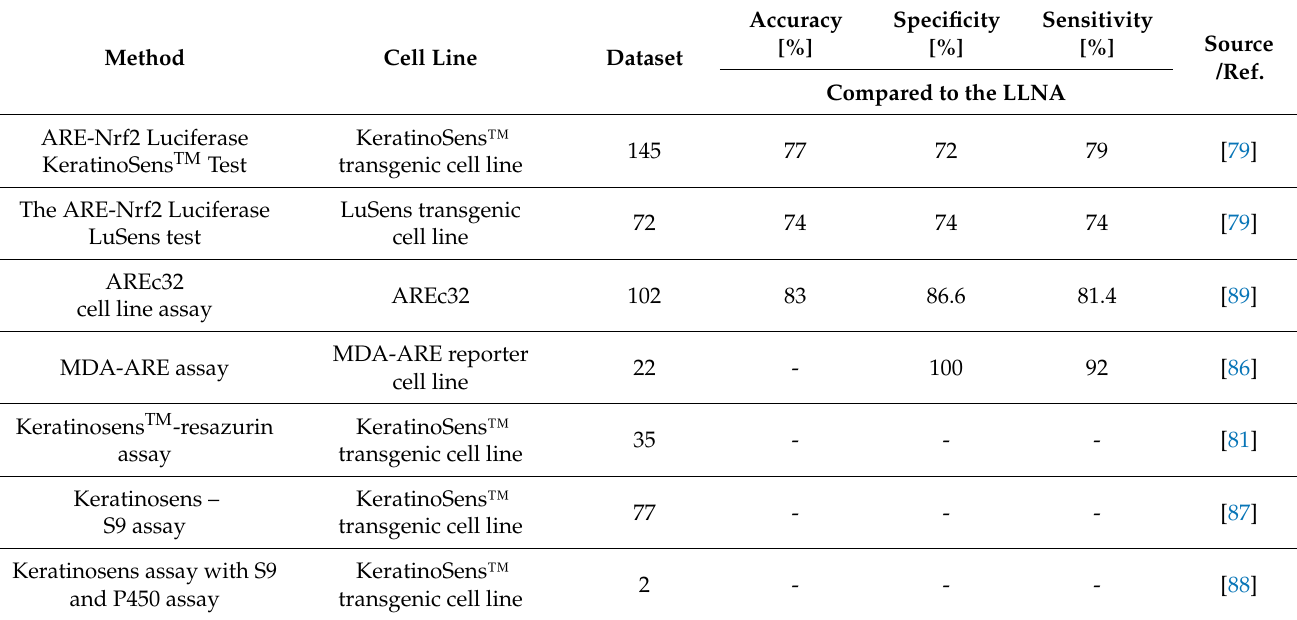
Table 3. KE2. Biochemical pathway based